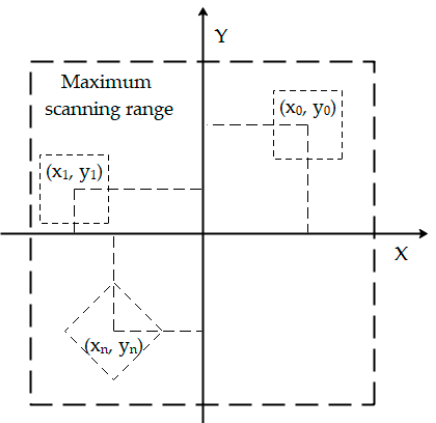
Figure 5. Scanning location, range, and angle setting by CSPM console.